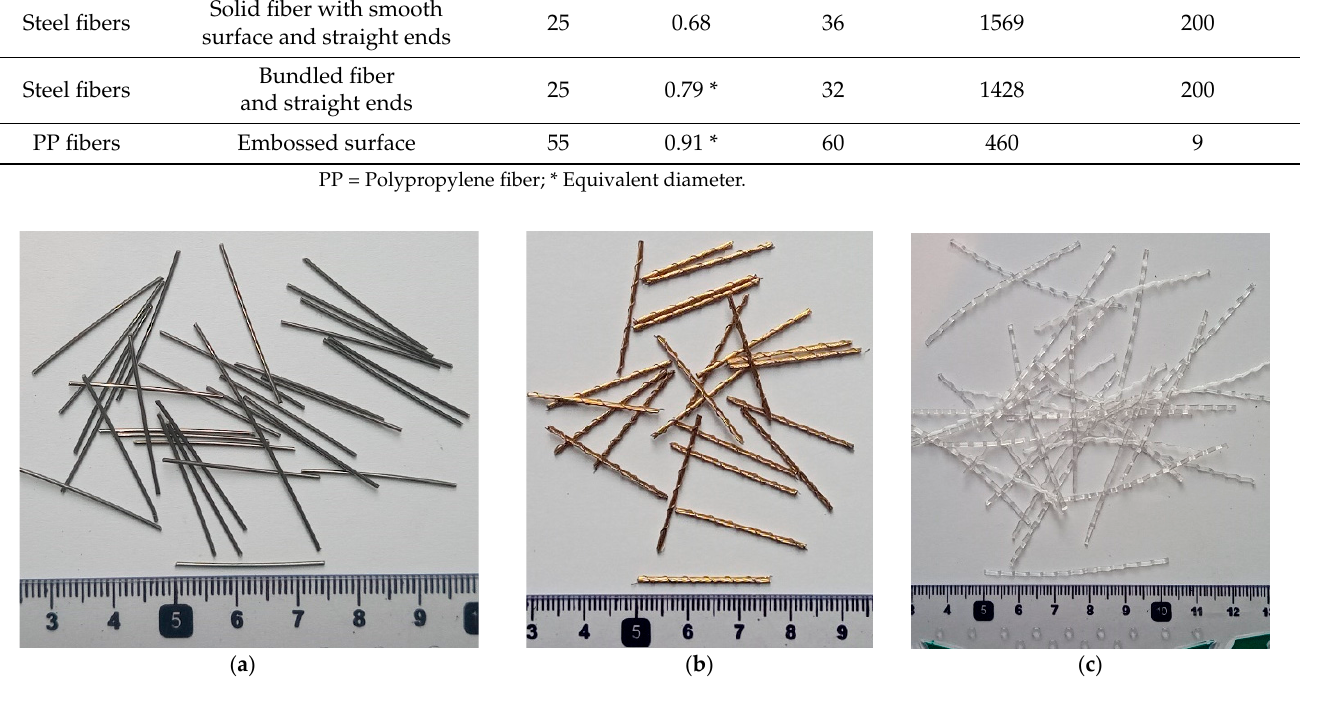
( b ) Figure 3. Structure of bundled steel fiber: ( a ) bundled steel fiber, ( b ) unwound steel wires. 4. Experimental Methodologies A pan ‐ type mixer with capacity of 56 L was used for mixing the concrete constituents, (Figure 4). Coarse aggregate, sand, and cement were initially dry ‐ mixed for three minutes. Next, the mixing water was added gradually. The mixing was continued for another three to five minutes. Lastly, fibers were added so as to avoid fiber balling, and the mixing was continued until the fibers were completely dispersed in the concrete. The slump and the fresh ‐ state density of concrete were measured immediately after the preparation of the mixture in accordance with ASTM C143 [55] and ASTM C138 [56], respectively. For the density of fresh concrete, a 9.3 L capacity cylindrical measure was placed on a vibrating table and filled in two layers. Each layer was given external vibra ‐ tions for consolidation. Cylindrical specimens with dimensions of 150 × 300 mm and pris ‐ matic specimens with dimensions of 100 × 100 × 350 mm were prepared from each mix ‐ ture. The consolidation of all mixtures was achieved in two layers using a vibrating table. The specimens were demolded after 24 h and cured for 28 days through water ponding to simulate the field curing of small ‐ diameter concrete pipes. The 150 × 300 mm cylindrical specimens were tested in compression for compressive strength according to ASTM C39 [57]. Plaster of Paris was used to cap the specimens be ‐ fore testing (Figure 5a). Continuous loading at a rate of 0.25 MPa/s was applied to the